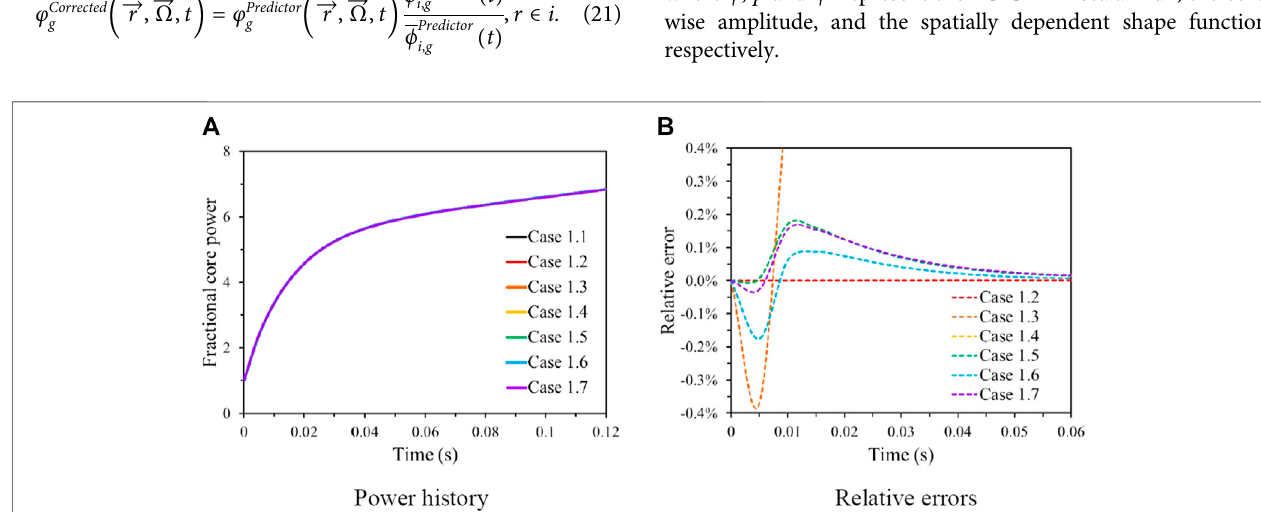
FIGURE 4 | Fractional core power results for heterogeneous UO 2 assembly problem. (A) Power history (B) Relative errors.